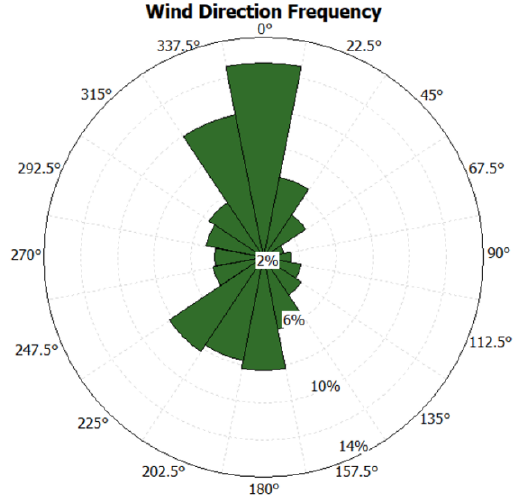
Figure 2. Wind direction rose of 5#.